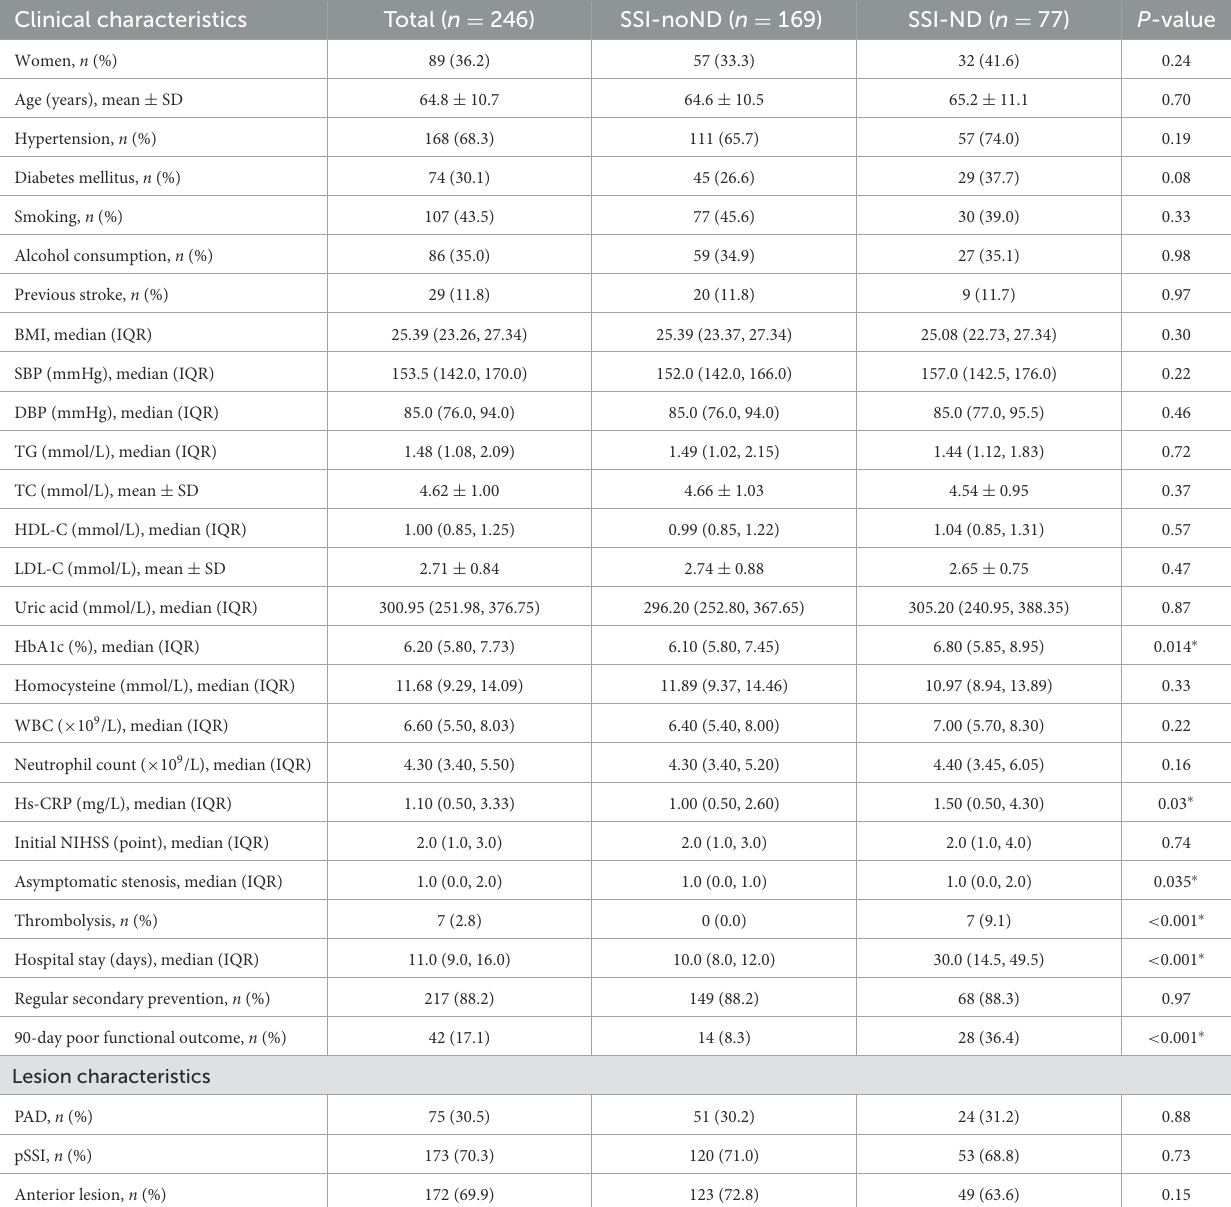
TABLE 1 Clinical characteristics of participants with and without